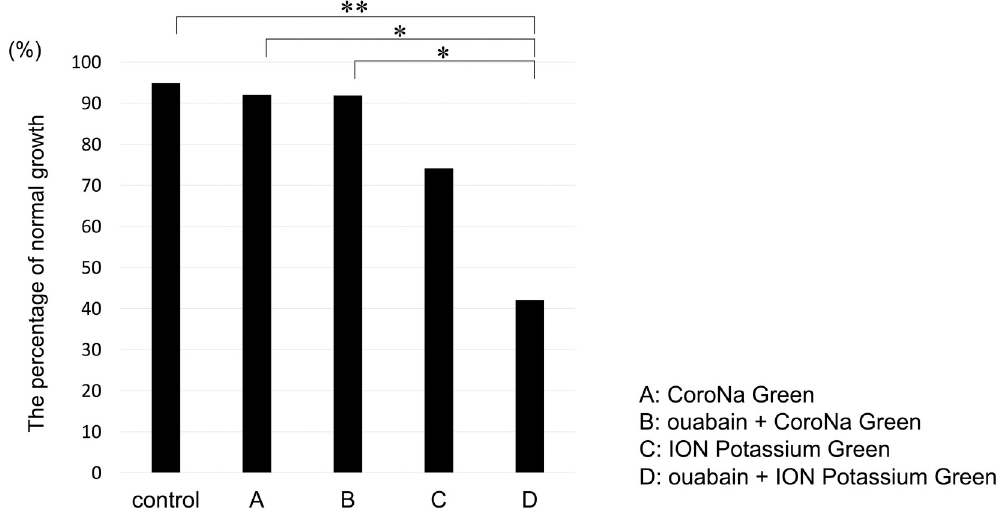
Fig 4. Comparison of normal growth after using electrolyte indicators with/without ouabain. (A) CoroNa Green AM (B) ouabain + CoroNa Green AM (C) ION Potassium Green-2 AM (D) ouabain + ION Potassium Green-2 AM. Normal growth was 94.9% (37/39) in control, 92.0% (23/25) in (A), 91.9% (34/37) in (B), 74.2% (23/31) in (C), and 42.1% (16/38) in (D). Fisher’s exact test and post-hoc pairwise comparisons adjusted using Holm’s method: � p < 0.05, �� p < 0.01. group, 74.2% (23/31) in the ION Potassium Green-2 AM group, and 42.1% (16/38) in the oua- bain + ION Potassium Green-2 AM group showed normal growth. Therefore, the ouabain + ION Potassium Green-2 AM group was significantly affected compared to the control (p = 0.0040), CoroNa Green AM (p = 0.041), and ouabain + CoroNa Green AM (p = 0.0192) groups (Fig 4), indicating that ION Potassium Green-2 AM was more cytotoxic than CoroNa Green AM, particularly in the ouabain combination group. (p = 1.000, control vs. CoroNa Green and ouabain + CoroNa Green groups; p = 0.129, control vs. ION Potassium Green) (Fig 4)